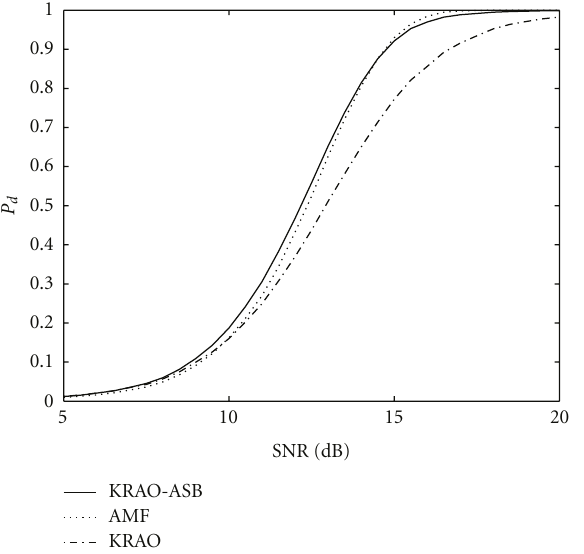
Figure 8: P d versus SNR for the KRAO-ASB with ρ = 1 . 2, the KWAS-ASB with γ = 1 . 1, and the AMF-RAO, N = 8, K =